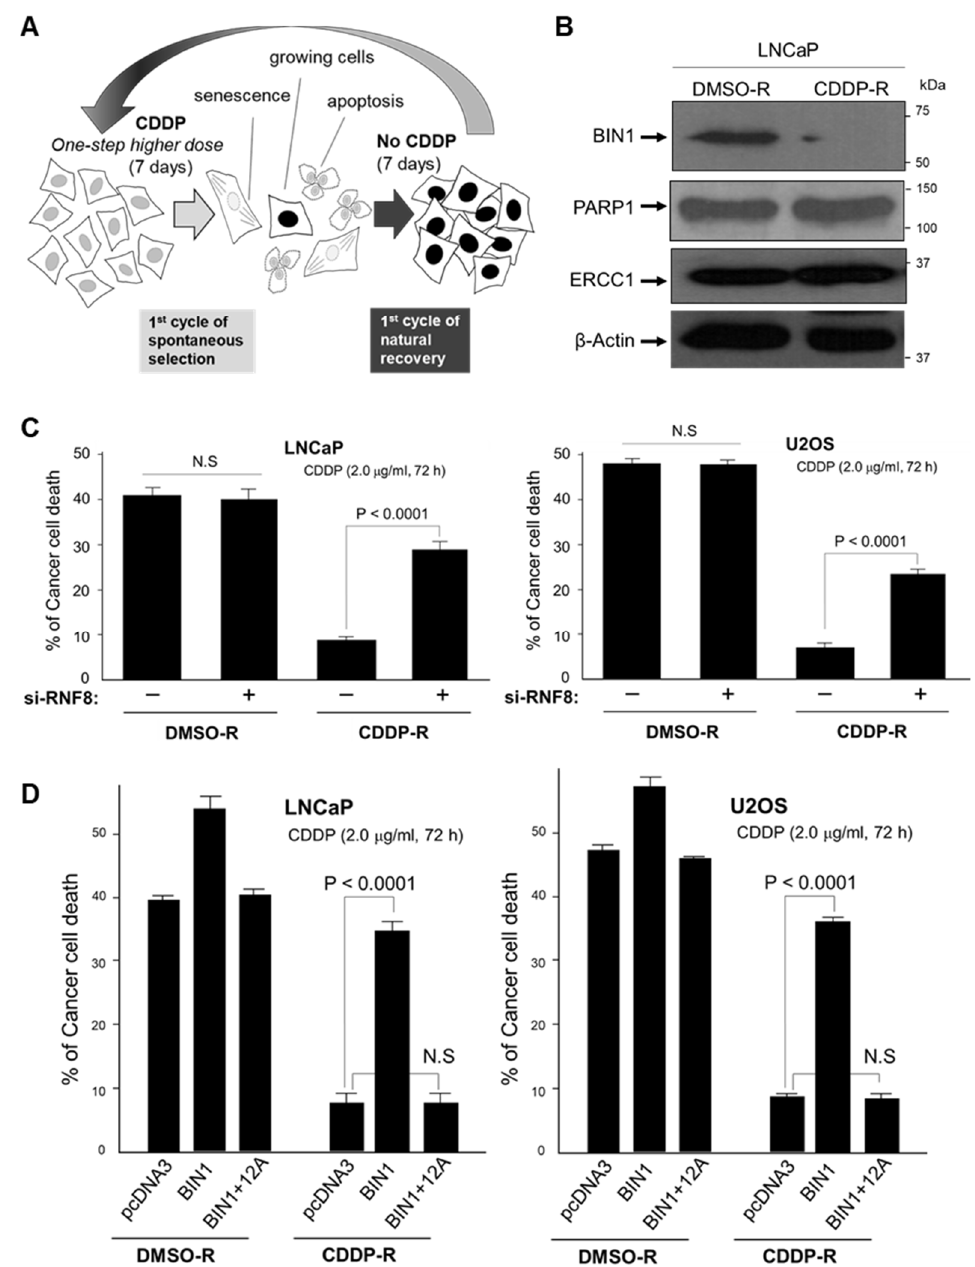
Figure 5. Spontaneous BIN1 loss and following RNF8-dependent cisplatin resistance emerge after long-term cisplatin exposure. ( A ) The establishment of spontaneous cisplatin (CDDP)-Resistant cancer cell lines (CDDP-R). The same parental cell line was incubated with 1/100 [ v / v ] of DMSO Repeatedly (DMSO-R) as the vehicle control cell line. The concentration of cisplatin of each treatment cycle was gradually increased from 0.5, 1.0, 2.0 to 4.0 µ g/mL; ( B ) Western blotting analysis of BIN1 , PARP1, and ERCC1 in the CDDP-R and DMSO-R cell lines. An open circle indicates a non-specific signal; ( C ) transiently transfected si-RNF8 restored cisplatin sensitivity in the CDDP-R cancer cell lines but not in the DMSO-R cell lines; ( D ) naturally acquired cisplatin resistance after long-term cisplatin exposure was balanced by transiently transfected BIN1 cDNA but not BIN1 + 12A cDNA. 2.6. Inhibition of PARP Activity Reverses Hyperactivated MYC-Dependent BIN1 Gene